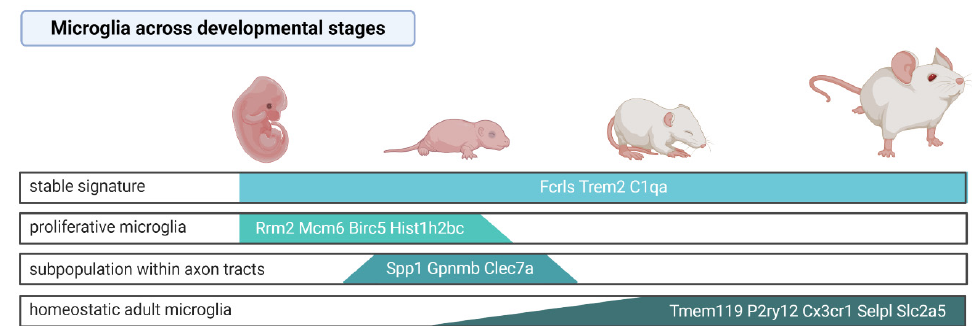
Figure 1. Microglia signature across mouse developmental stages based on the single-cell studies. Created with BioRender.com (accessed on 8 March